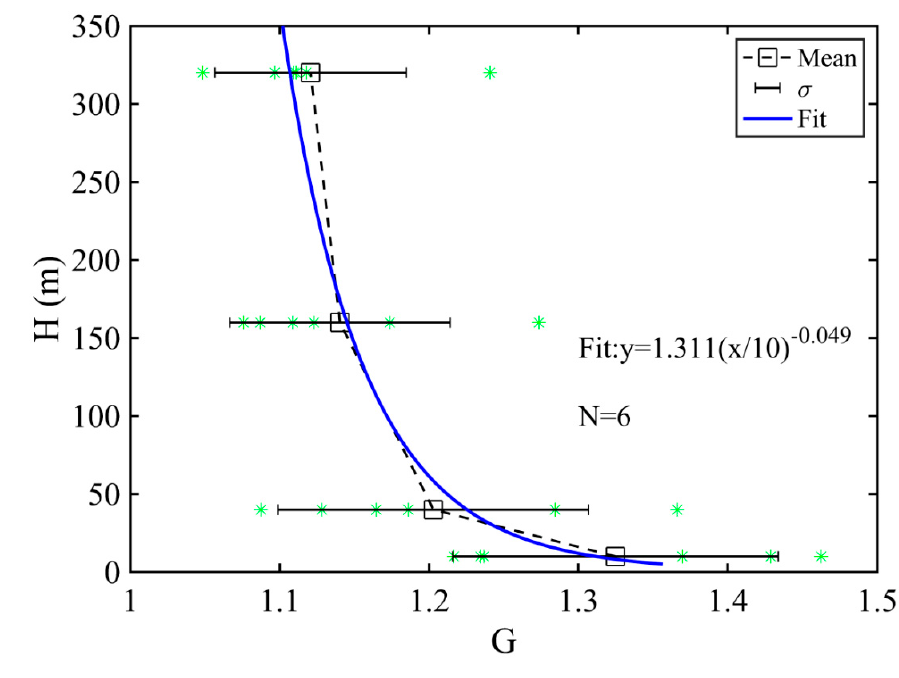
Figure 7. Gust factor profile of all 6 events.